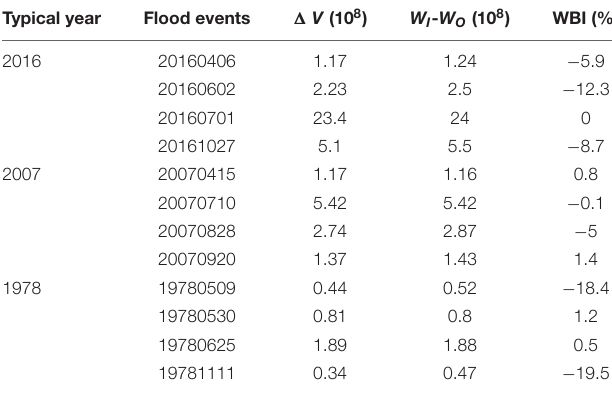
TABLE 2 | Performance of water balance during flood events.